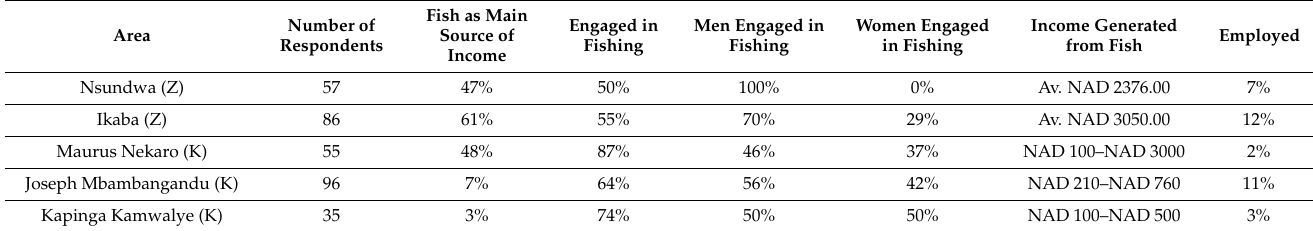
Table 2. Selected results from Frame surveys in five communities, focusing on fish as a source of livelihood. (Z = Zambezi River; K = Kavango